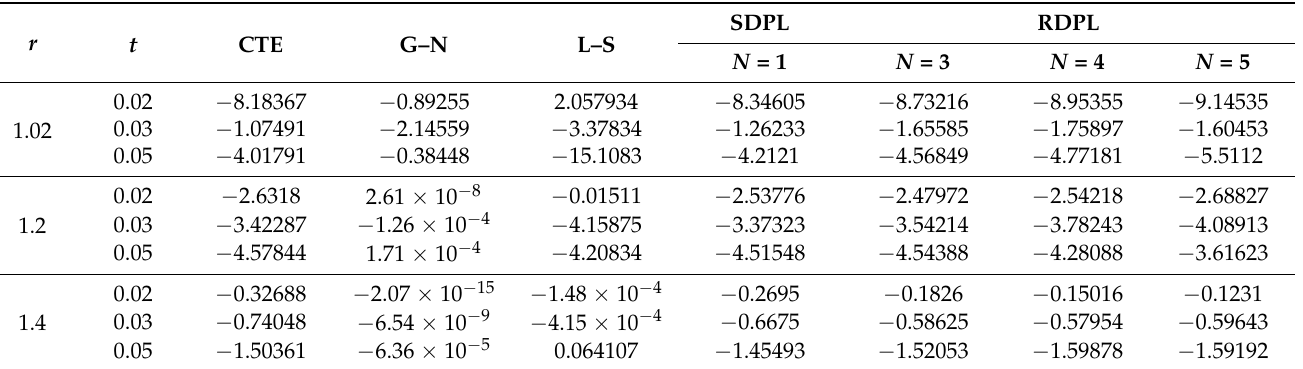
Table 4. Effects of dimensionless time t on radial stress σ 1 according to different thermoelasticity theories with several values of r .